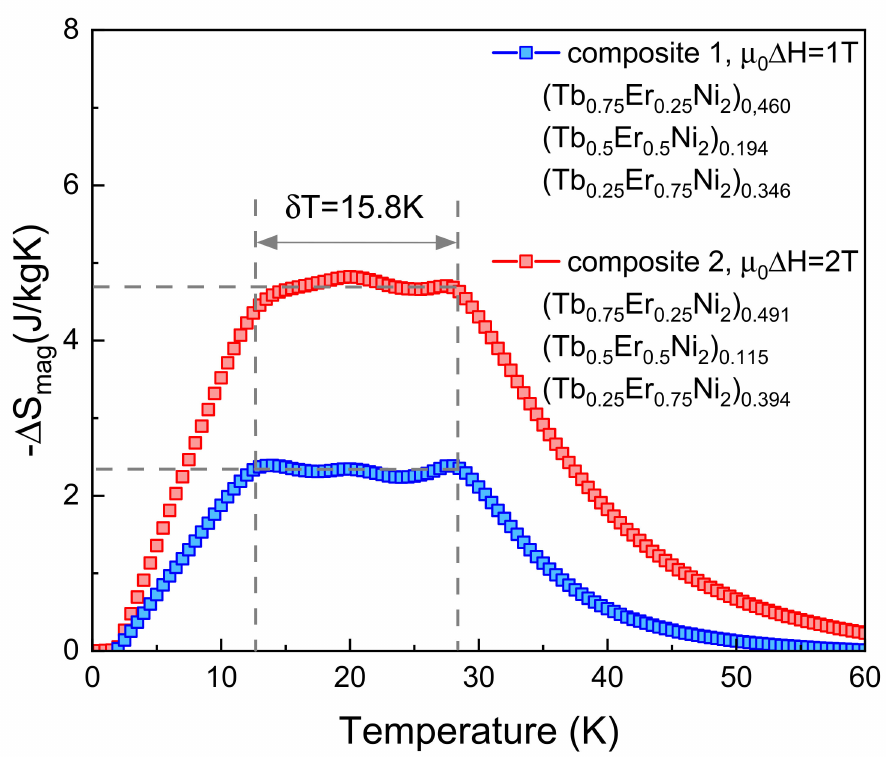
Figure 3. Temperature dependences of the isothermal magnetic entropy change − ∆ S mag (T) for composites based on the investigated compounds for the magnetic field change of 1 and 2